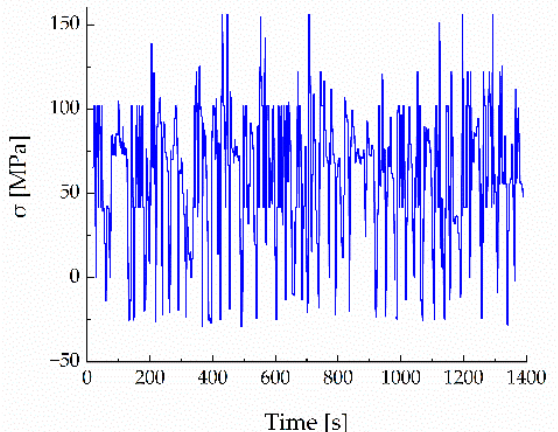
Figure 12. Bending stress load spectrum of electromagnetic braking.